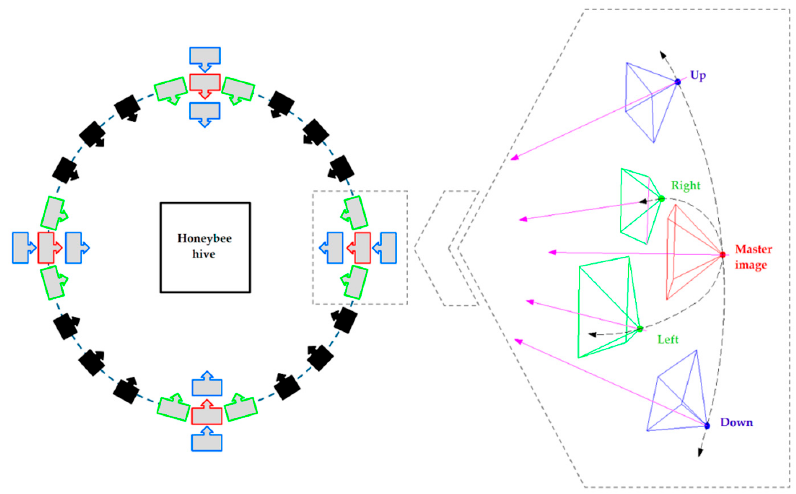
Figure 2. “Master” and “slave” images following a “ring” in the data acquisition protocol.